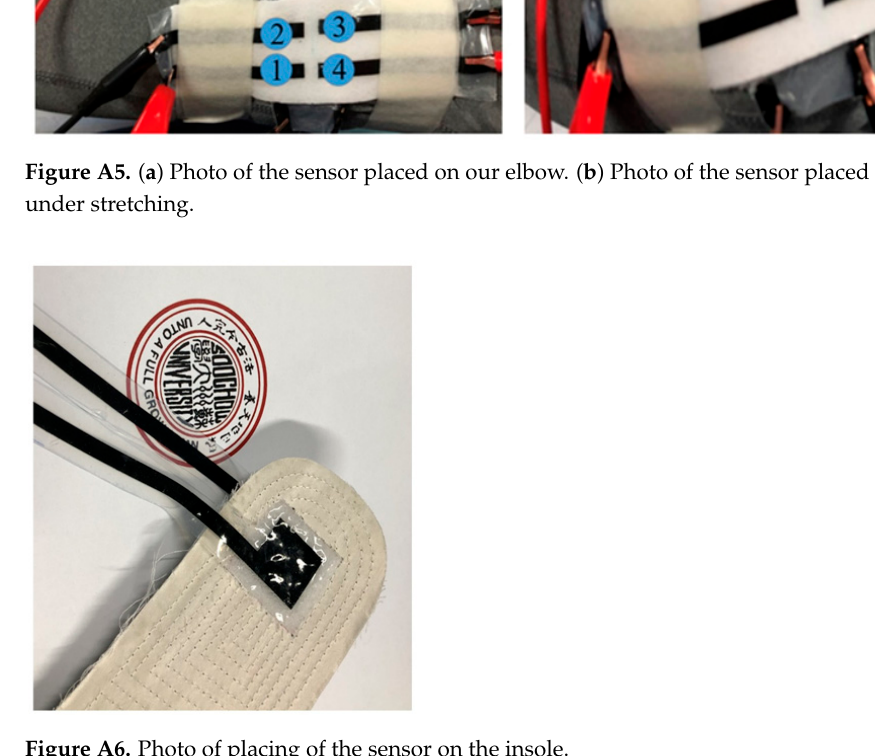
contains a collection chip and a computer.